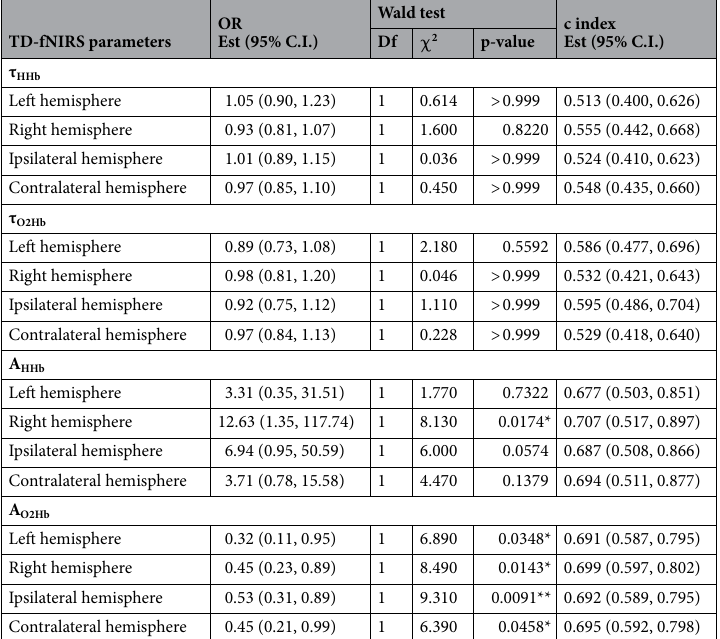
Table 2. Association and discriminant ability of TD-fNIRS parameters recorded at single hemisphere. Results obtained by estimating 16 distinct logistic models including a single independent variable. Each p-value and each confidence interval were adjusted for the multiplicity of tests using the Bonferroni rule. Column 1: TD-fNIRS parameters ( A peak amplitude, τ = peak latency, O 2 Hb oxy-haemoglobin, HHb deoxy-haemoglobin). Column 2: estimated OR ( Est estimates). Column 3: tests of association between parameters and pathological classification of eyes ( Df degrees of freedom. χ 2 Chi-square statistics. *p < 0.05; **p < 0.01). Column 4: estimates of the concordance index